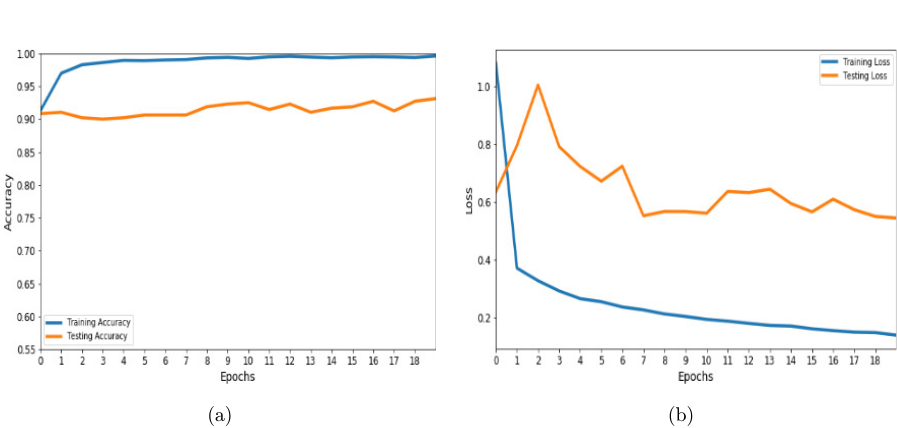
Fig. 8. Graph of the VGG16 þ FCN model: (a) Epochs vs. Accuracy (b) Epochs